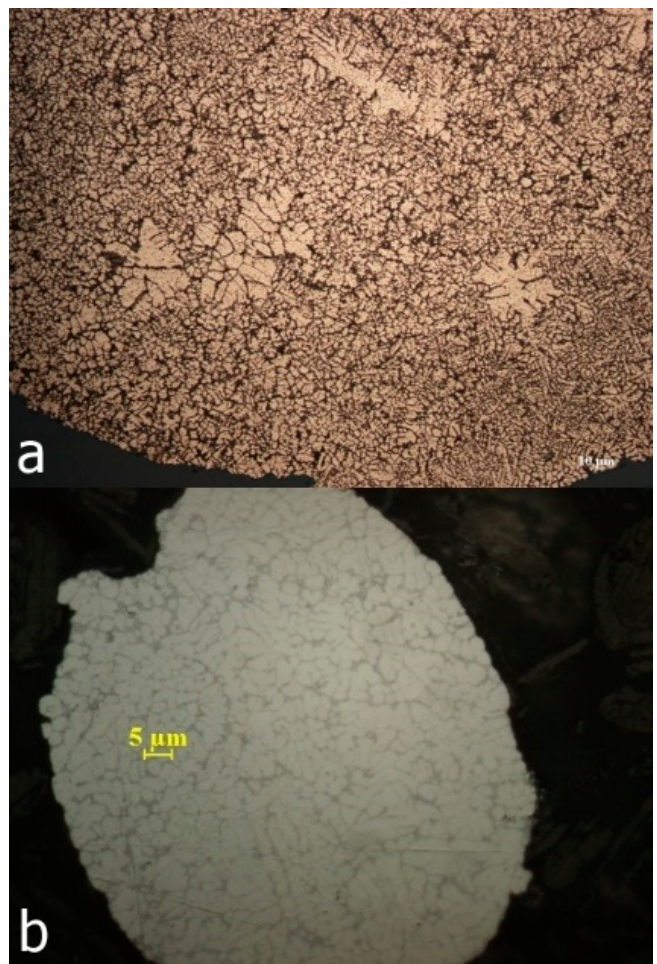
Figure 3. Powder structure obtained by atomization of Al 79 Si 11 Ni 10 alloy with high pressure, in water ( a ); the structure of commercially available powder ( b ).